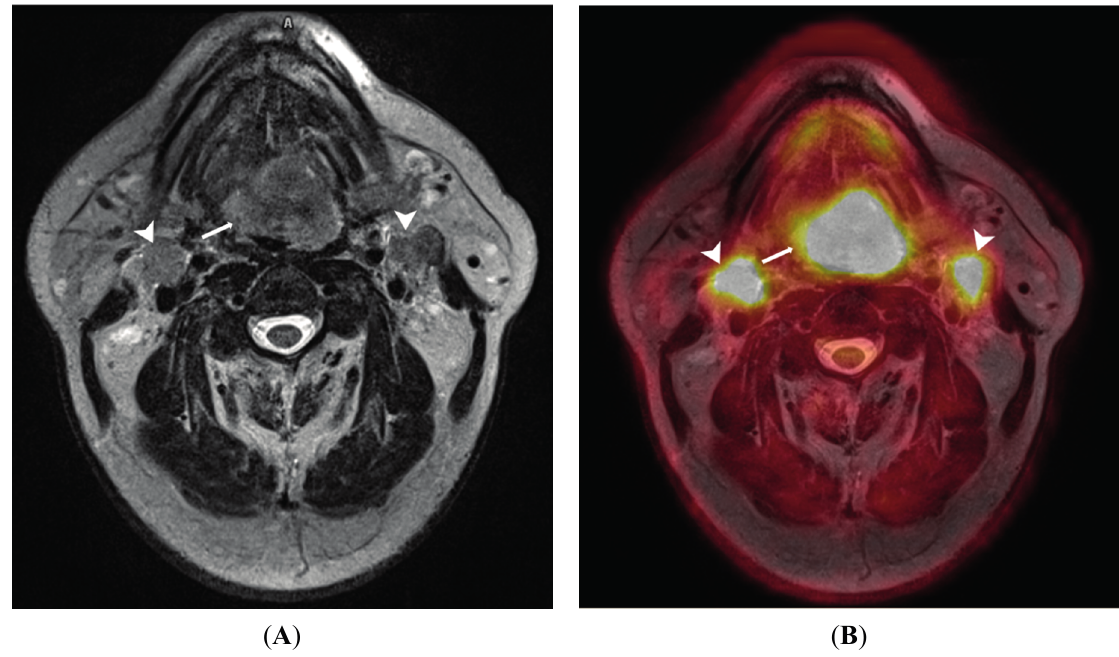
Figure 3. A 65-year old male patient with lingual carcinoma ( A ) T2-weighted MRI and ( B ) 18 F-FDG PET/MRI. The primary tumour (arrows) and nodal metastases (arrowhead) are considerably more conspicuous on PET/MRI compared with T2-weighted